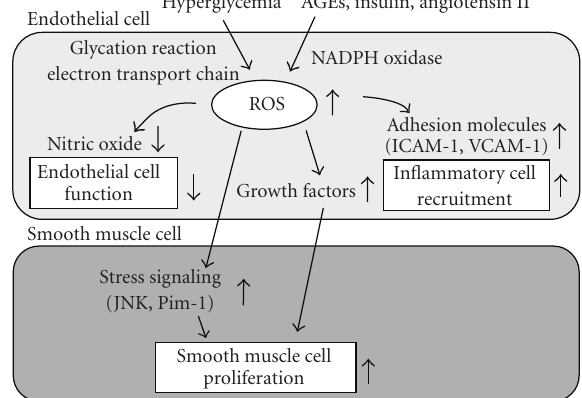
Figure 4: Role of ROS in the development of atherosclerosis. ROS are produced by various pathways under diabetic conditions and involved in the development of atherosclerosis in various aspects. Hyperglycemia induces ROS through activation of the glycation reaction and electron transport chain in mitochondria. Also, AGEs, insulin, and angiotensin II induce ROS through activation of NADPH oxidase. Increased ROS are involved in the development of atherosclerosis in various aspects. First, ROS decrease nitric oxide levels, which leads to endothelial cell dysfunction. Second, ROS increase expression of various adhesion molecules such as ICAM- 1 and VCAM-1, which leads to inflammatory cell recruitment. Finally, ROS increase expression of various growth factors and activate various stress signaling such as JNK and Pim-1, which leads to proliferation of smooth muscle